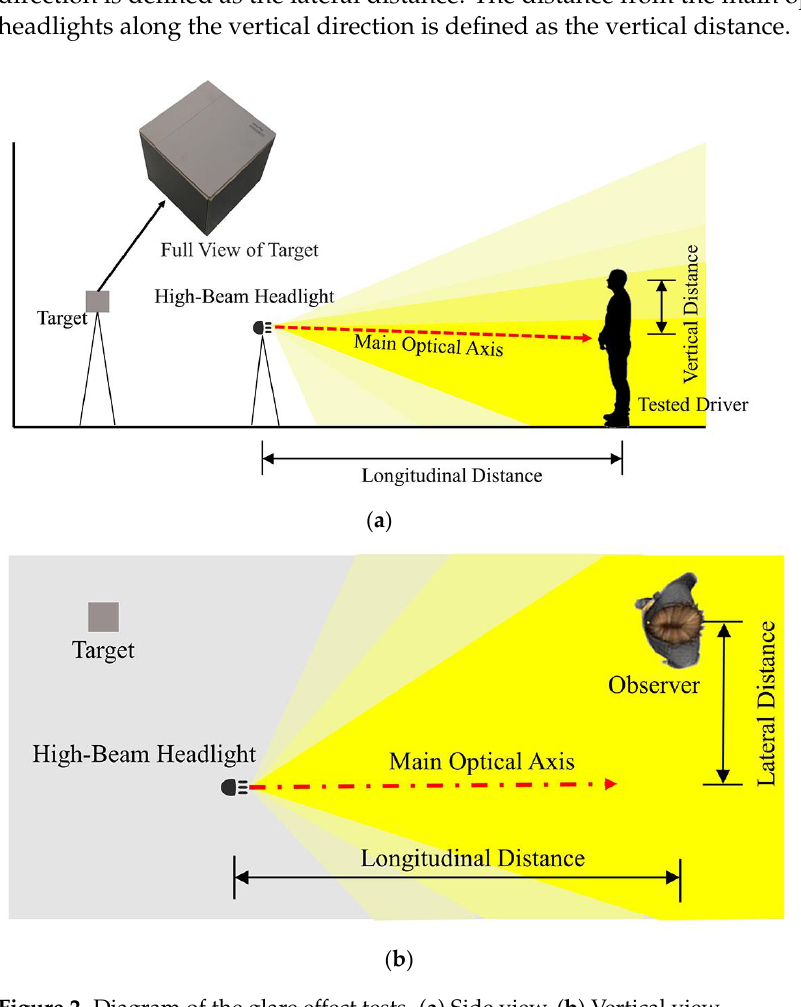
Table 1. Subjective headlight glare scale and relevant description.